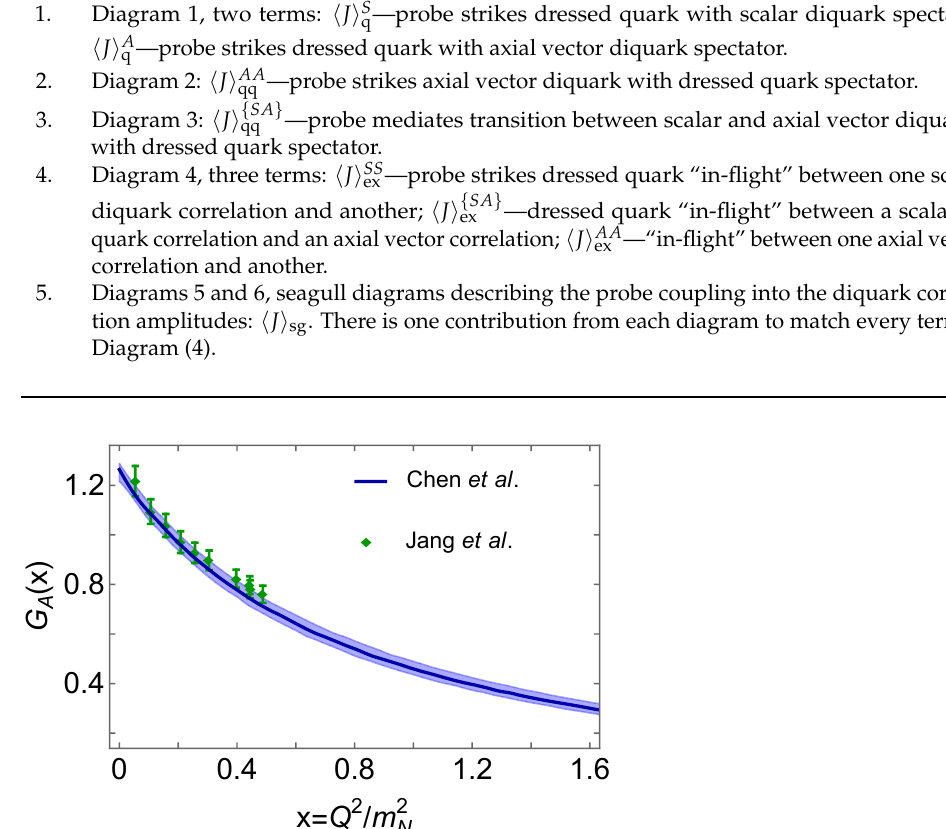
Table 2. Enumeration of terms in the baryon axial vector/pseudoscalar current, drawn in Figure 14.